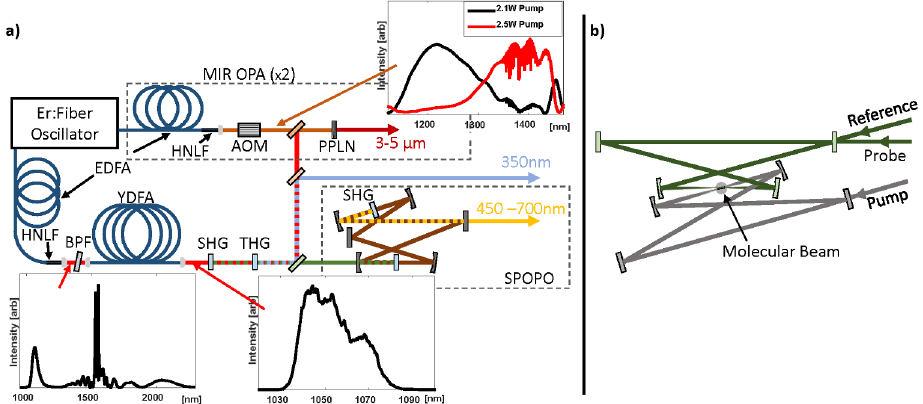
Fig. 1. a.) Layout for the generation of tunable optical frequency combs in UV, visible, and MIR spectral regions. Typical spectra are included for HNLF output, amplified 1050 nm pump, and tunable near-infrared signal combs. b.) Experimental cavity layout, a gas slit nozzle is used to generate a molecular beam at the foci of two crossed ring cavities for the enhancement of both pump and probe light. Reference cavity is used for noise subtraction